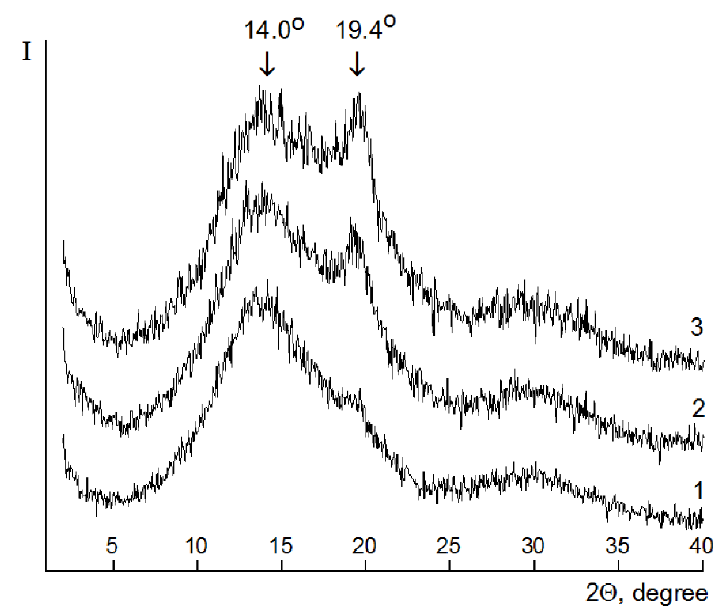
Figure 14. X-ray diffraction patterns of the 80/20 PVA-PAA compositions obtained according to mode 1 (composition 1): 1—original composition; 2—composition 1 containing 1 wt.% of untreated carbon NTs; 3—composition 1 containing 1 wt.% of carbon NTs with surface carboxyl groups.